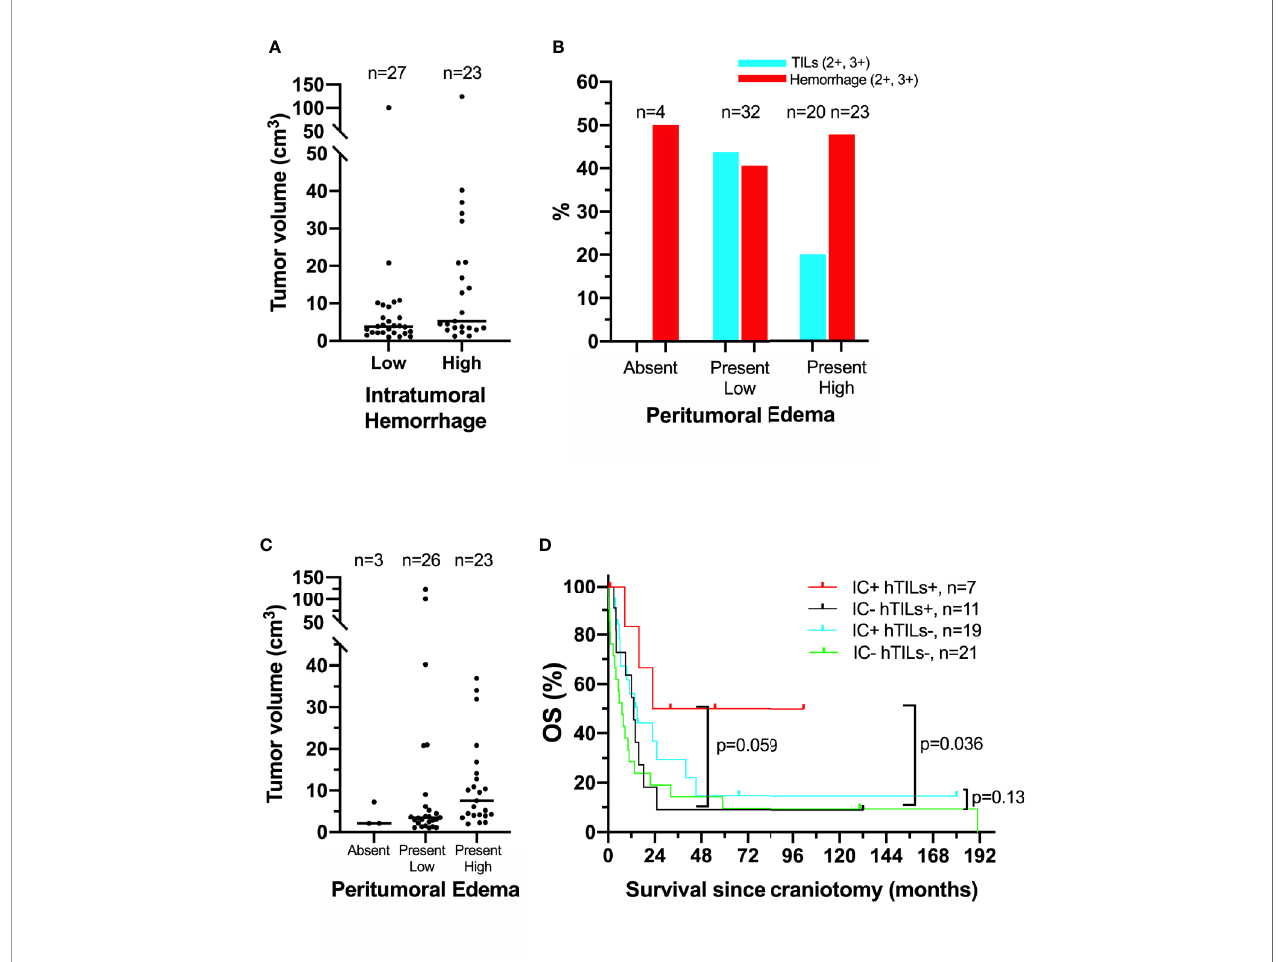
FIGURE 1 | Association of clinical, histopathologic, and radiographic features in the University of North Carolina at Chapel Hill melanoma craniotomy cohort. See methods for details: (A) individual tumor volumes with high (2+, 3+) versus low/absent (0, 1+) intratumoral hemorrhage, as measured by histopathologic analysis on hematoxylin and eosin (H&E)-stained representative tissue sections. (B) Incidence of high (2+, 3+) tumor-in fi ltrating lymphocytes (hTILs) and intratumoral hemorrhage, as measured by histopathologic analysis on H&E – stained tissue sections, in relation to the degree of peritumoral edema, as measured by brain magnetic resonance imaging. (C) individual tumor volumes in brain tumors with absent, present/low, and present/high peritumoral edema. (D) Exploratory survival analysis (Kaplan-Meier method) according to the presence of hTILs, as measured by histopathologic analysis on H&E-stained tissue sections and treatment with immune checkpoint inhibitors (IC) following